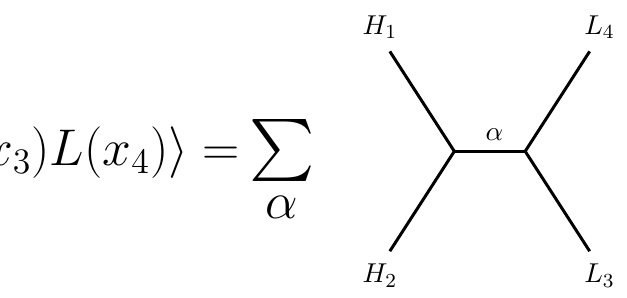
Figure 1 . BMS block expansion of a four-point function. The heavy operators are labeled as \H", while the light ones are labeled by \L". The choice of channel corresponds to the two heavy oper- ators interchanging a BMS highest weight representation with the light operators. The exchanged representation is labeled by (cid:11)